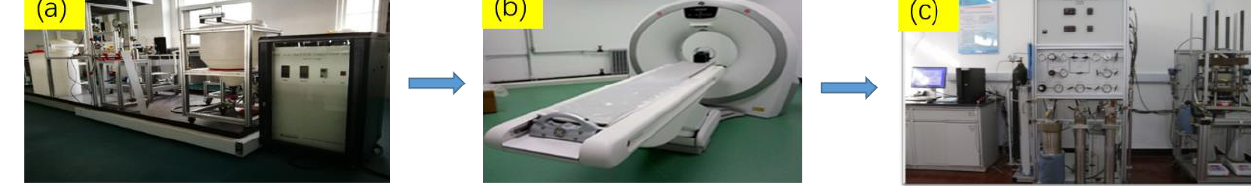
Figure 3. Equipment for acid etching and conductivity test : ( a ) Rock slab acid etching device, ( b ) CT scanner, ( c ) Fracture conductivity test Table 3. Acid-etching experimental scheme.